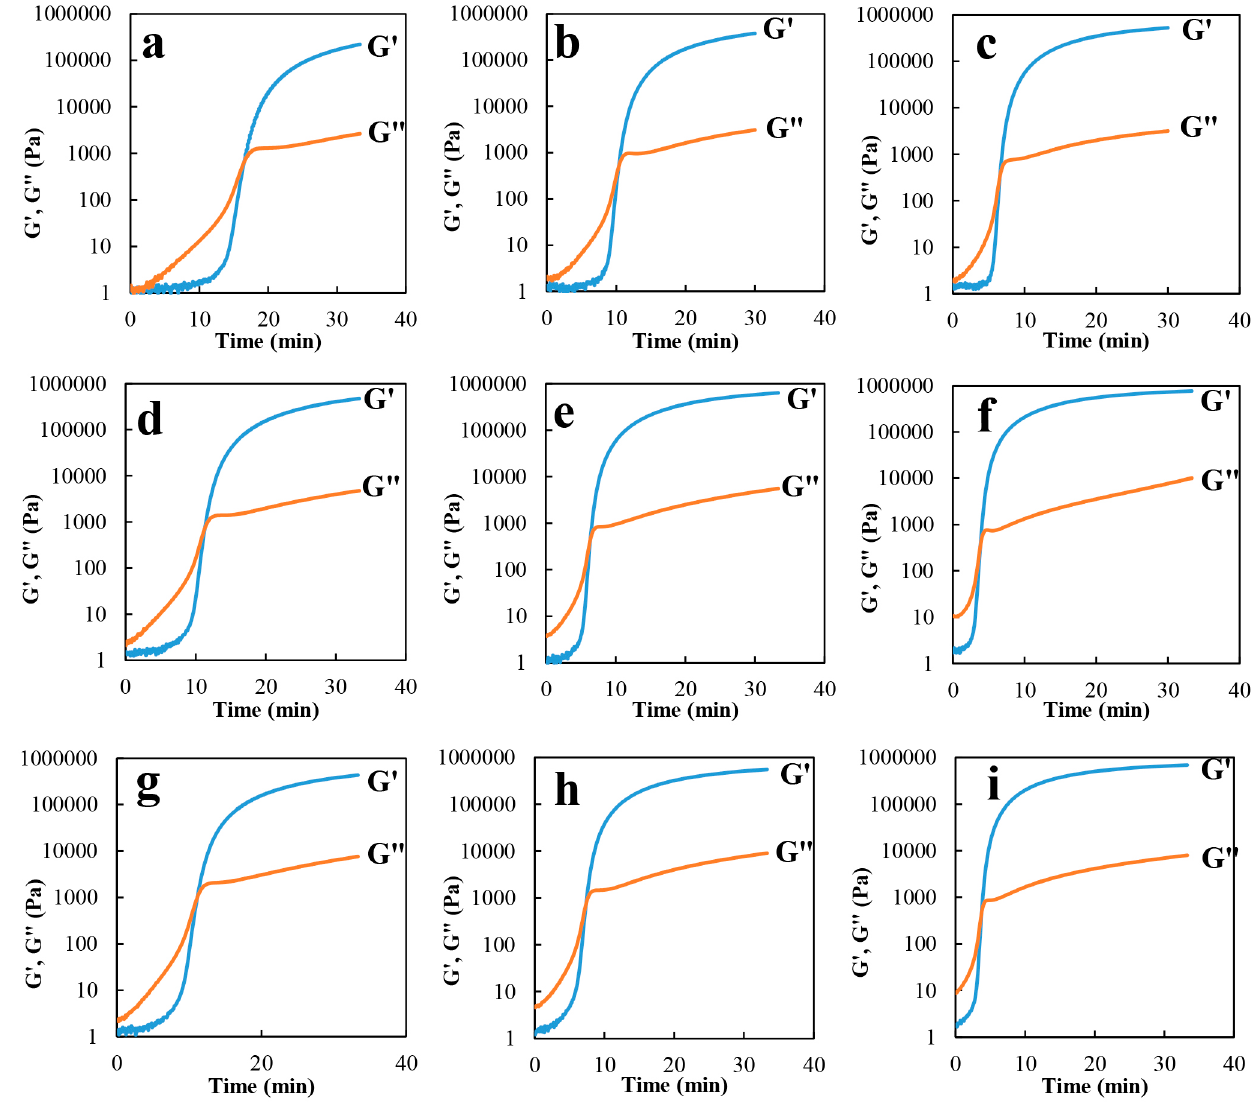
Figure 4. Rheological diagrams of epoxy resin/0.5% UFNBRP at ( a ) 65 °C, ( b ) 70 °C and ( c ) 75 °C; rheological diagrams of epoxy resin/1% UFNBRP at ( d ) 65 °C, ( e ) 70 °C and ( f ) 75 °C; rheological diagrams of epoxy resin/1.5% UFNBRP at ( g ) 65 °C, ( h ) 70 °C and ( i ) 75 °C.